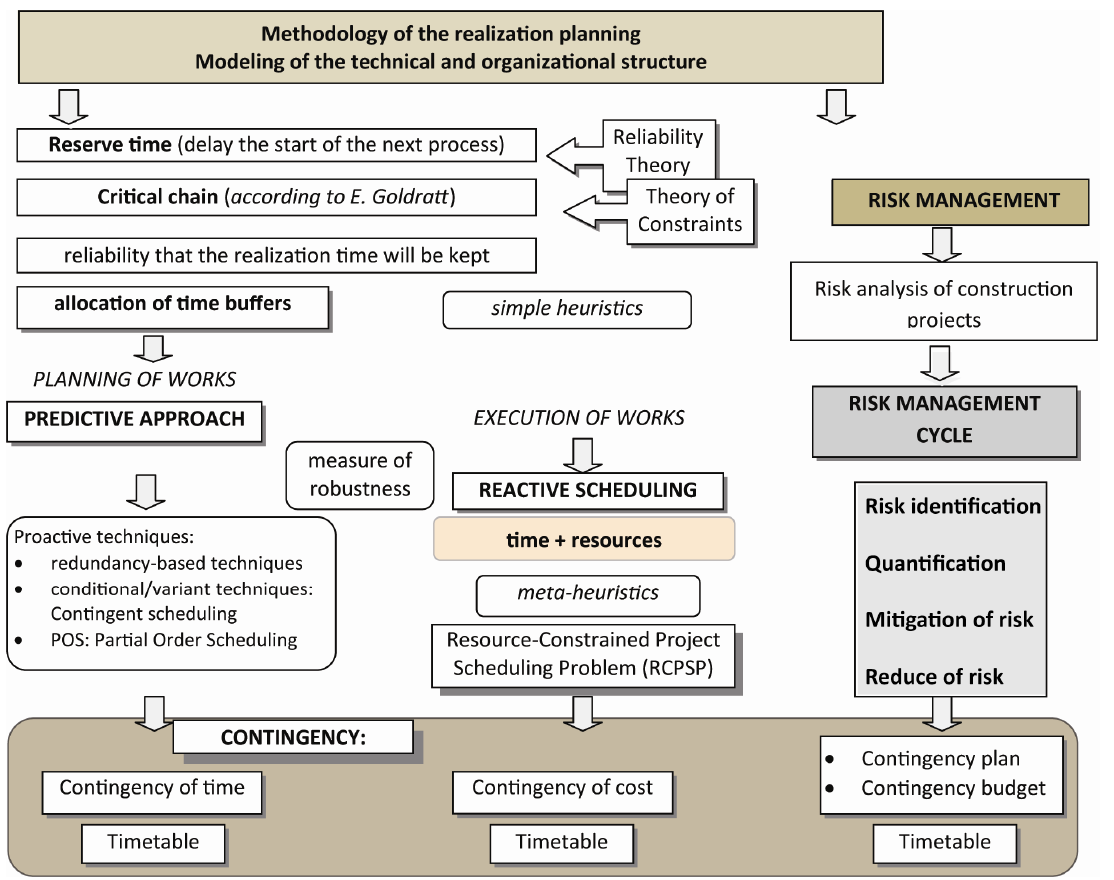
Fig. 3. The evolutionary path between reliability and contingency (Kapli ñ ski